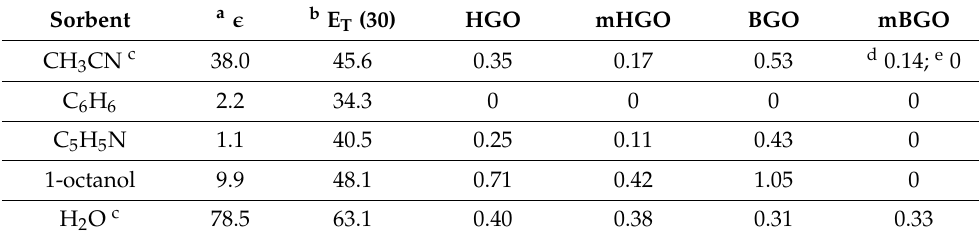
Table 2. Sorption (g/g) of polar and nonpolar solvents at T = 298 K.